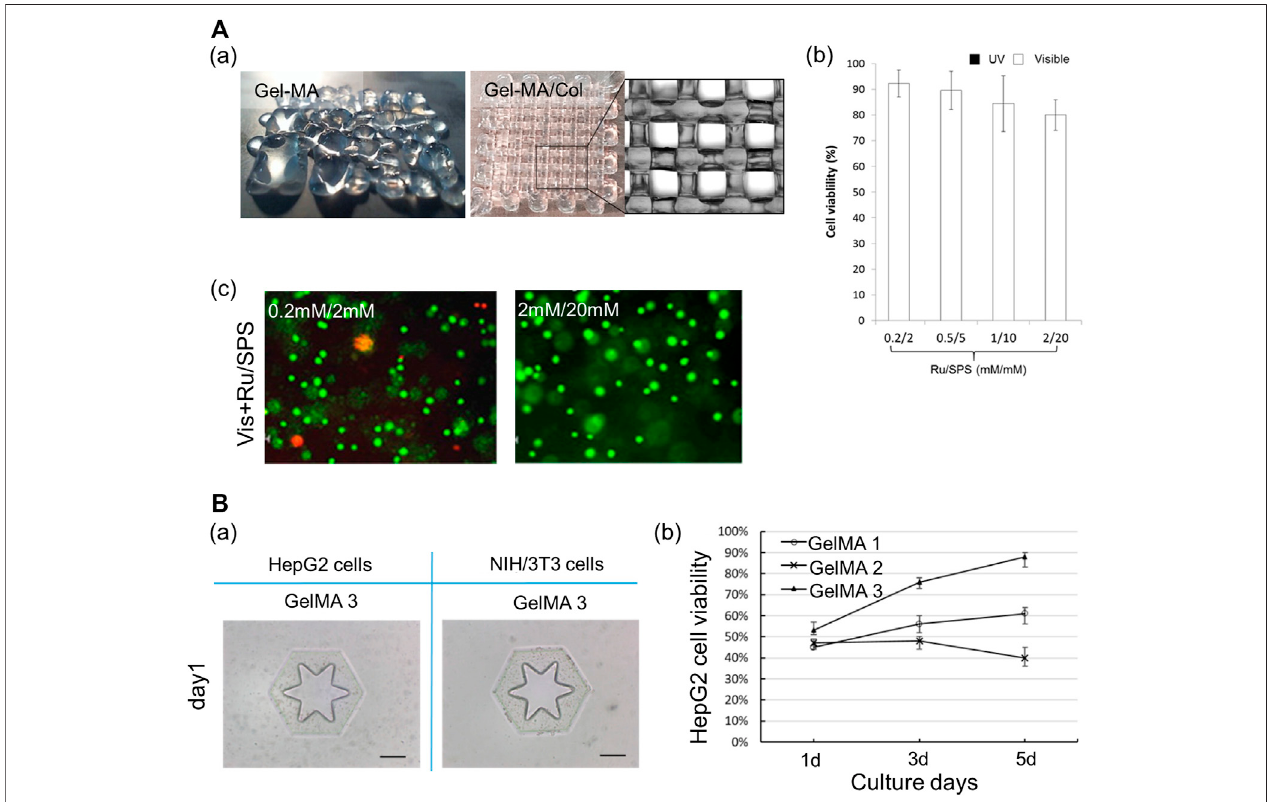
FIGURE5| Gelatin-basedmulticomponentbioinks. (A) CharacteristicsofhybridbioinkofGelMAandcollagen.(a)Shape fi delityoftheacellularconstructfabricated by GelMA and hybrid bioink of GelMA and collagen. Scale bar: 1 mm. (b) Cell viability of the MCF-7 encapsulated in GelMA/collagen with different Ru/SPS concentrations. (c) Live dead images of MCF-7 encapsulated in the hybrid bioink of GelMA and collagen with photoinitiator Ru/SPS (0.2 mM/2 mM and 2 mM/20 mM). Scale bar = 100 μ m. Reproduced with permission from Lim et al. (2016). (B) Characteristics of GelMA. (a) Shape fi delity of the cell-laden construct fabricated by GelMA 3. Scale bar: 200 μ m. (b) The viability of HepG2 cells respective encapsulated in GelMA 1, GelMA 2, and GelMA 3 during 5 days culture. Reproduced with permission from Cui et al. (2019).